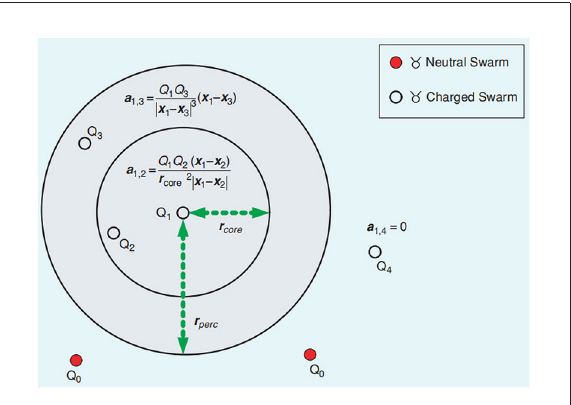
FIGURE3 Interaction of the charged swarm robots (Jatmiko et al., 2007).